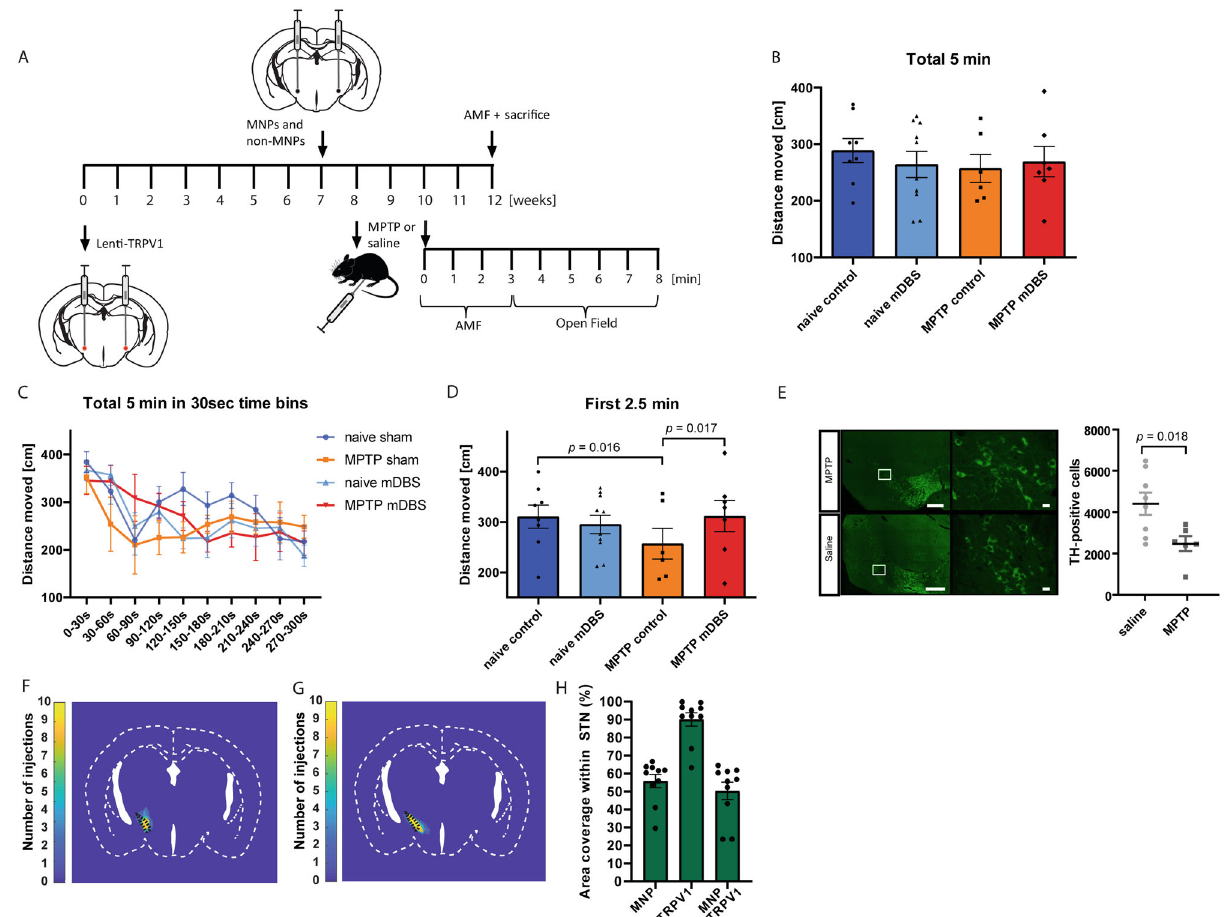
Fig. 3 Magnetothermal STN DBS alleviates mild parkinsonian symptoms. A In vivo experimental scheme for the translational study. B Total distance moved (in cm) in the open fi eld ± S.E.M. for naive control ( n = 8), naive mDBS ( n = 10), MPTP control ( n = 6), and MPTP mDBS ( n = 7) mice. There was no signi fi cant difference between the groups when considering the total 5 min, one-way ANOVA: F(3,305) = 1.46, n.s. C When presenting the data in 30 s time bins, it is apparent that MPTP mDBS animals reduced locomotor behavior after the fi rst 2.5 min of the open fi eld. Data presented as mean ± S.E.M. D Total distance moved (in cm) in the fi rst 2.5 min of the open fi eld ± S.E.M. There was a signi fi cant difference between naive controls and MPTP controls, as well as MPTP controls and MPTP mDBS mice as con fi rmed by one-way ANOVA followed by Fisher ’ s least signi fi cance test: F(3,150) = 2.488, p = 0.016 and p = 0.017, respectively. E Representative photomicrographs of TH-positive cells for saline ( n = 8) and MPTP-treated ( n = 6) animals in the